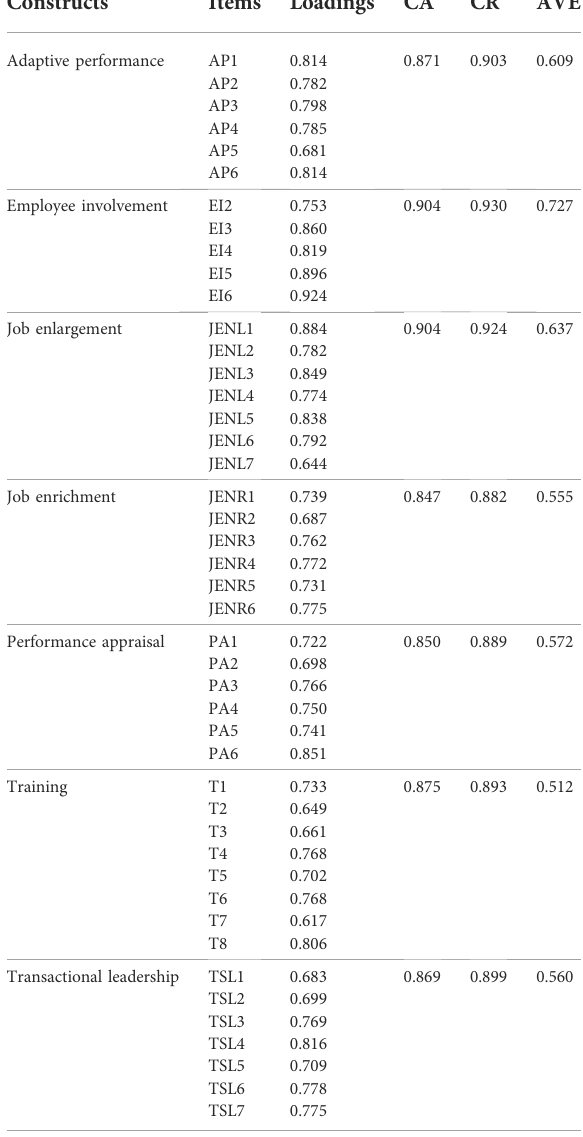
TABLE 1 Constructs ’ validity and